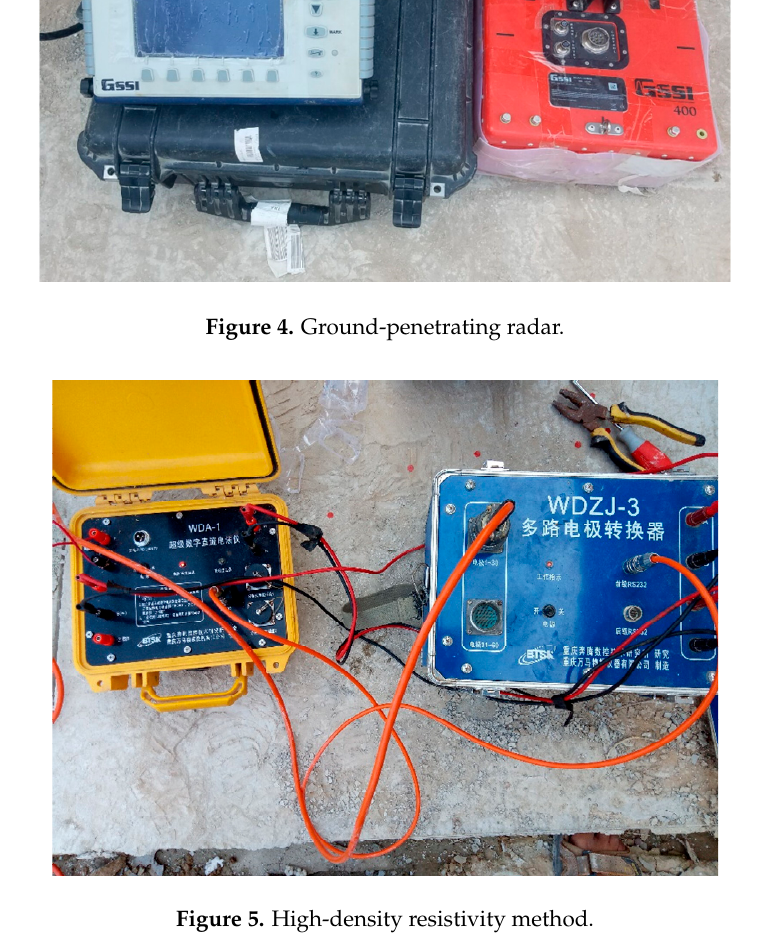
Figure 6. The layout of GPR and HDRM. 3. Discussion of Laboratory Results 3.1. Gelation Time of the Slurry The test results in terms of gelation time of the slurry are shown in Figure 7. The gelation time prolongs as fly ash content increases. When partly replacing cement with fly ash and bentonite, the water over cement ratio (W/C), that is a key factor in determining the setting time, decreases. In particular, the backfilled bentonite influences the hydration of cement and prolongs the gelation time. In practice, a slurry with appropriate gelation time is of great significance to avoid small range diffusion or water erosion. Therefore, the gelation time of slurry needs to be adjusted without greatly changing the slurry property by adding specific amount of fly ash.